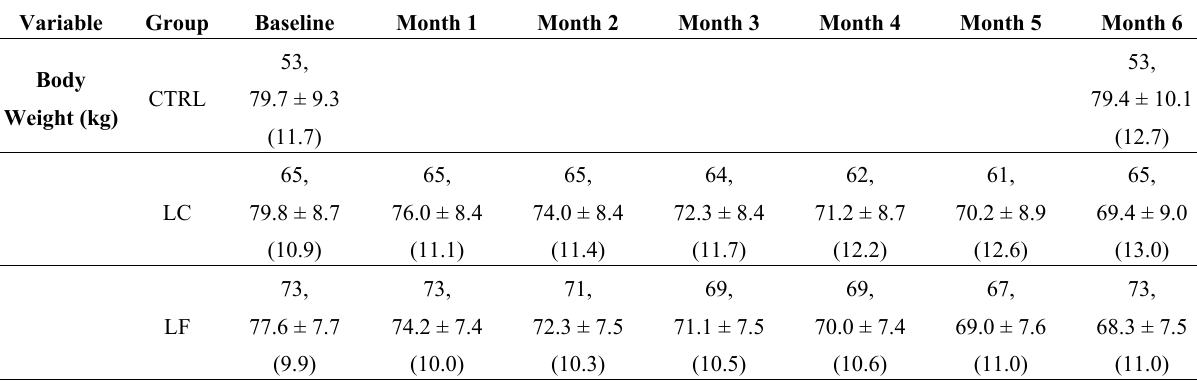
Table 1. Anthropometric measurements over time 1